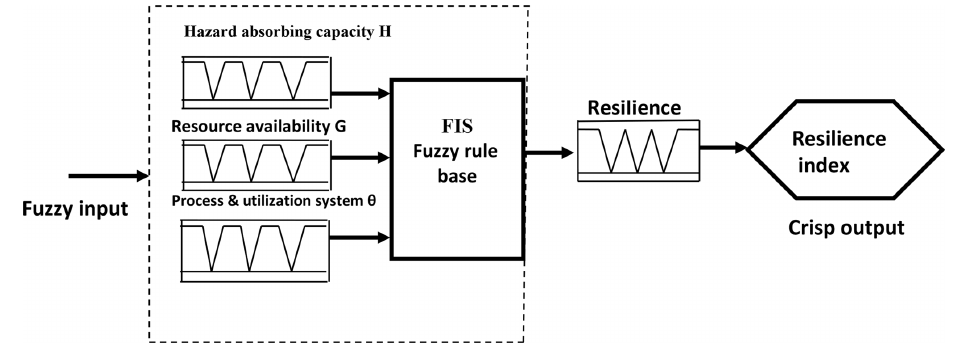
Figure 7. Resilience fuzzy inference systems. Table 3. Sample rules of the R-FIS 27 rule base (rules and weights to be determined by experts and/or